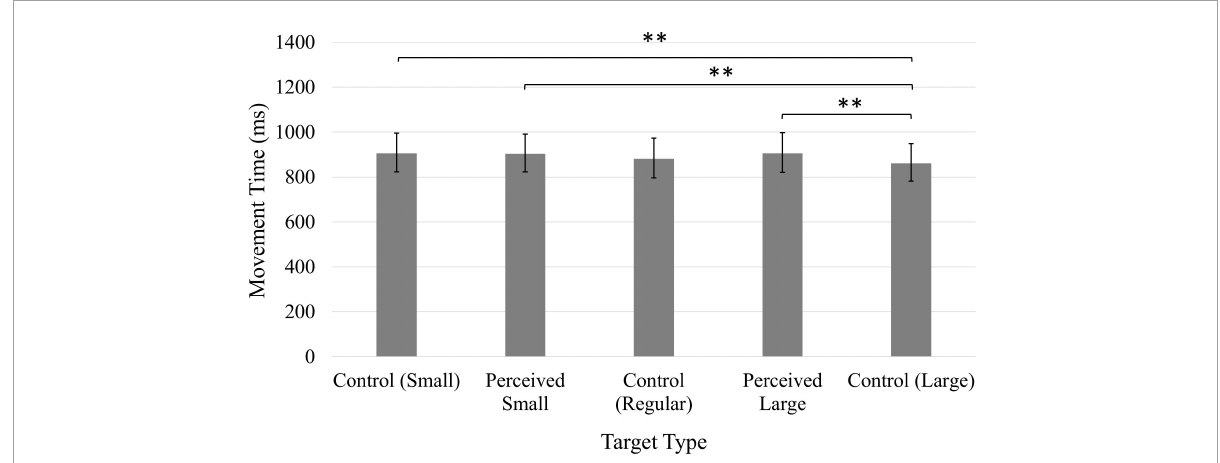
FIGURE6 Average movement time (ms). Error bars represent 95% confidence intervals. ∗∗ p < 0.01.